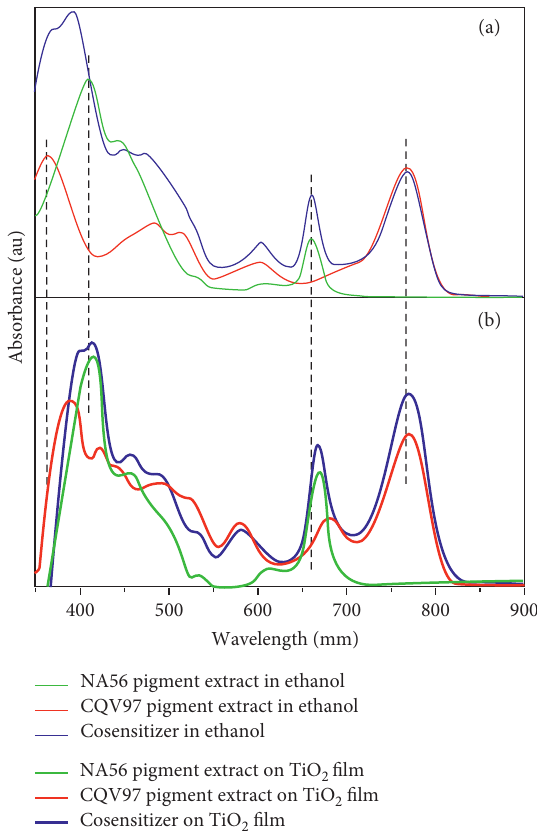
Figure 1: UV-Vis absorption spectra of NA56 and CQV97 pigment extracts, and the cosensitizer of them in ethanol (a) and on the TiO